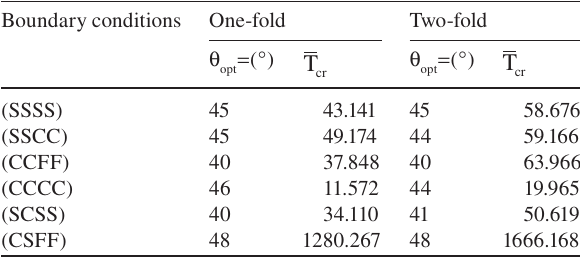
Table 2 Effect of boundary conditions on the optimum fi ber orientations for one-fold and two-fold laminated composite